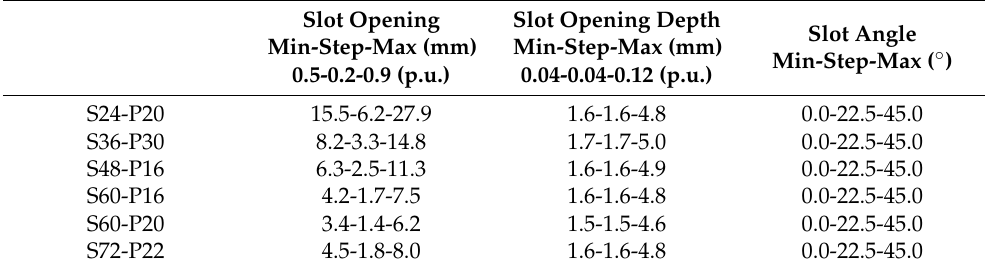
Table 6. Design aspects and performance indicators.